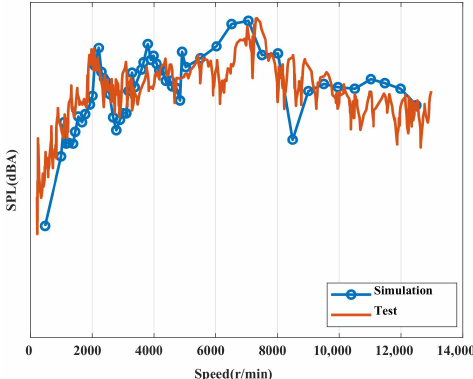
Figure 8. Simulation and test comparison of rear 1